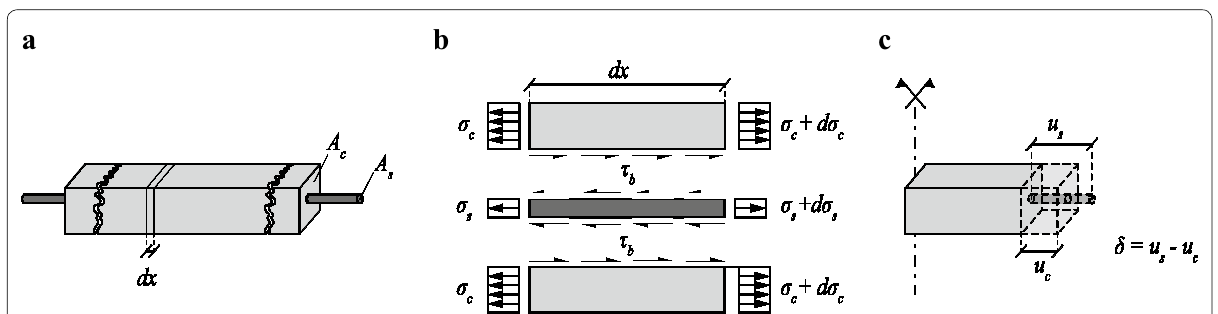
Fig. 1 After (Marti et al. 1998): a Sketch of a basic tension chord element, i.e. the portion of tension chord between two cracks. b Concrete and steel equilibrium for an infinitesimal length dx . c Compatibility